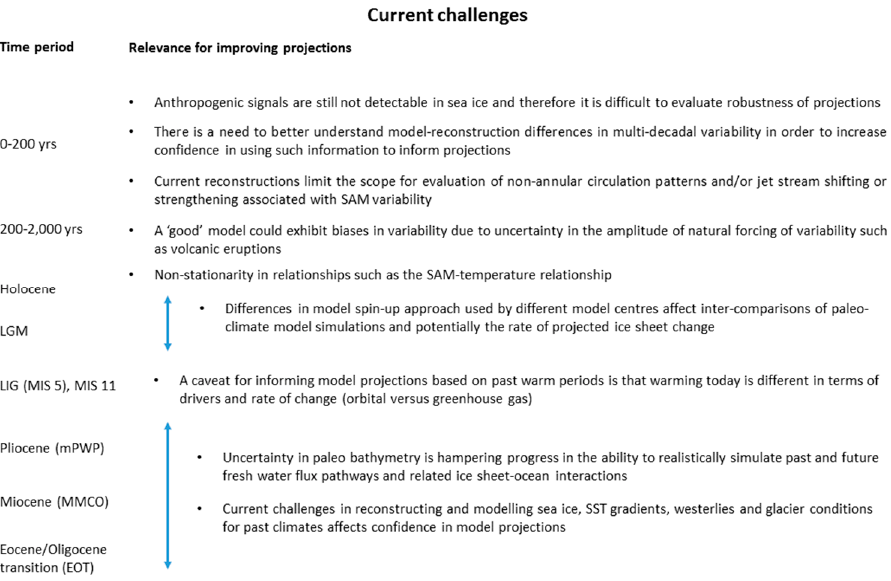
Figure 4. As Figure 2 but from the sections on ‘next steps’. Looking to the future, our overall conclusion is that closer integration between the climate reconstruction and climate modelling communities would be of great benefit for improving the reliability of projections of future Antarctic climate change. This should be achieved through a combination of: (i) extending the range of climate model outputs to better match key climate proxies, (ii) feeding long-term reconstruction datasets into community standard climate modelling metrics, (iii) encouraging participation in PMIP or other project simulations as a high priority for model centers and (iv) regular workshops and meetings to encourage collaboration and sharing of tools and data across the modern and paleo climate communities. This approach is encouraged by SCAR, whose future scientific plan under development will follow an integrated research approach across the existing SCAR working groups to encourage multi-disciplinary research of past to future polar sciences and provide more reliable projections of Antarctic climate and ice sheet contribution to global mean sea level rise.